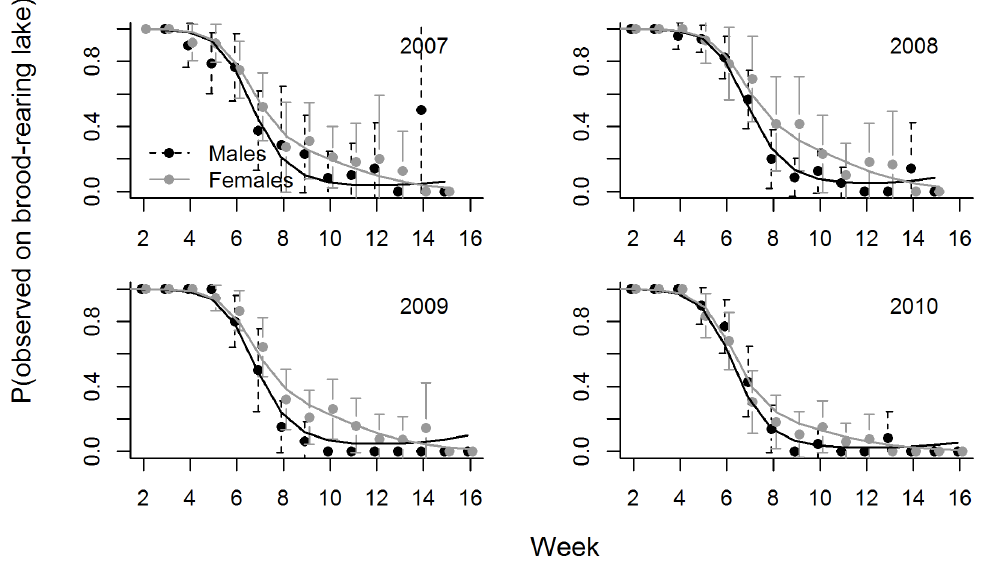
Figure 5. The probability that juvenile ring-necked ducks were observed on brood-rearing lakes. Open circles correspond to observed proportions (with 95% confidence intervals) during falls of 2007–2010. Black and gray lines give predictions from the ‘best-fit’ generalized estimating equation model (chosen using QIC) for males and females, respectively.